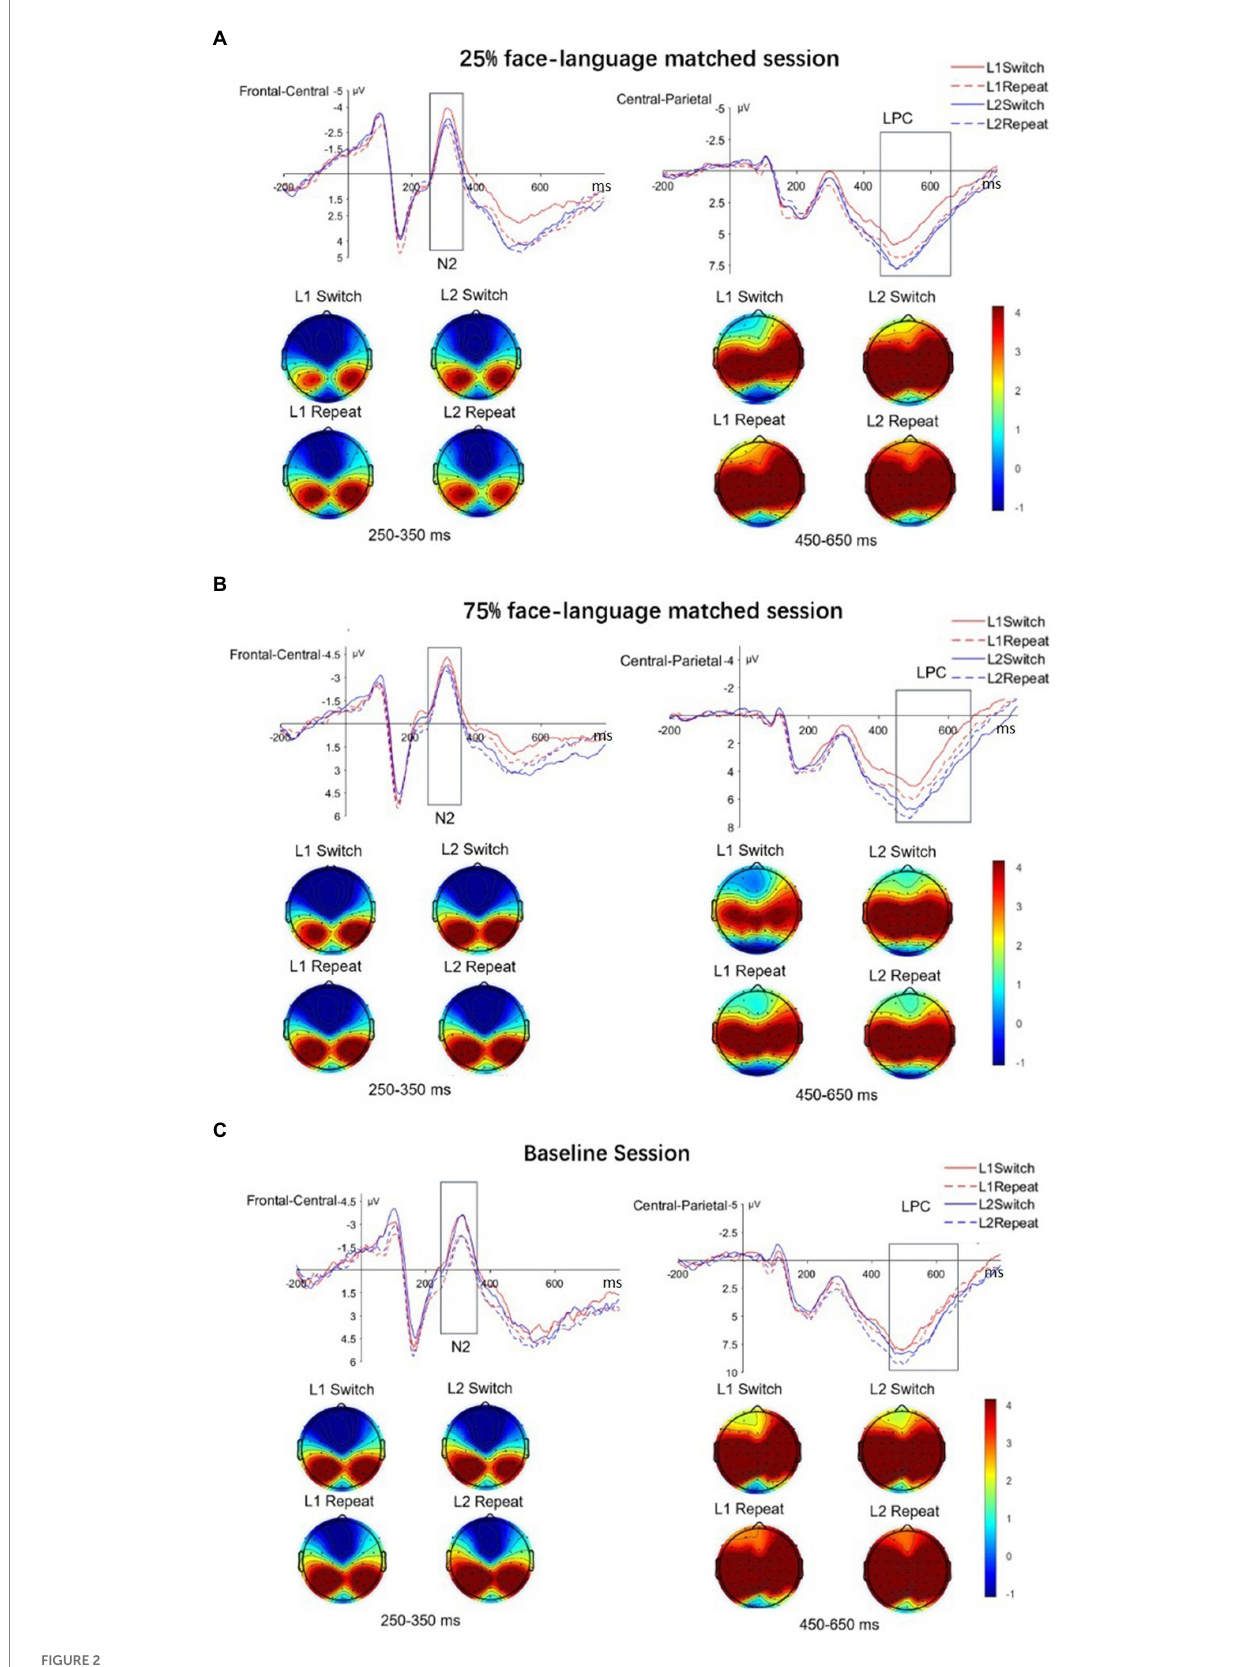
FIGURE 2 The grand average waveforms and topographic maps for (A) 25% face-language matched session, (B) 75% face-language matched session, and (C) baseline session per Language and Trial type. The upper panel displays grand average waveforms time-locked to the onset of the stimulus pictures for the two Trial types (Switch, Repeat) across two languages (L1, L2) in frontal-central and central-parietal regions. Red = L1; blue = L2; solid line = Switch; dotted line = Repeat. The lower panel exhibits topographic maps for each condition in the frontal-central and central-parietal